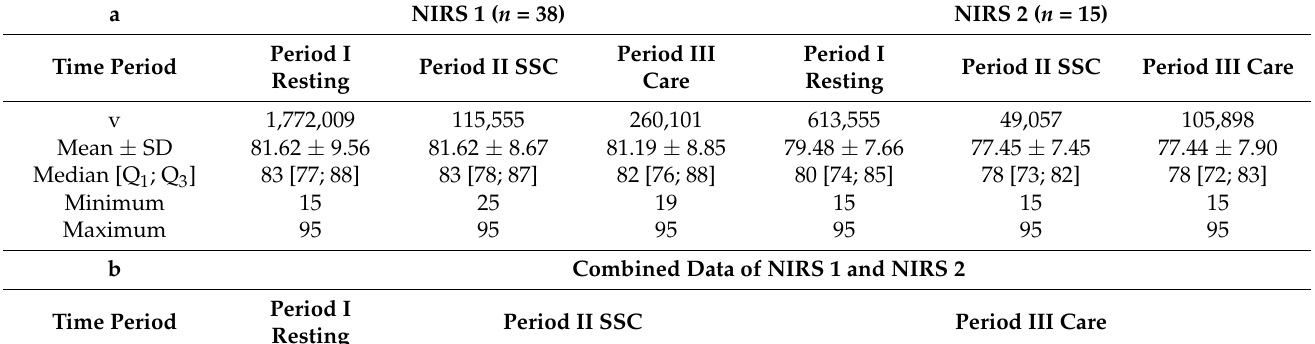
Table 3. a, b: Regional cerebral oxygenation (rcSO 2 ) in % during period I (resting time) period II (skin-to-skin-contact; SSC) and period III (handling) for infants with SSC based on all available values (3a) or median values (3b) of infants during each period with an overview of the number of values per infant, which were used to evaluate the median value per infant. The results of the generalized linear model (GLMM) are shown in the last part (3c). Predictions using the estimate and standard error have to be rescaled for the 0–1-problem and the [15; 95] interval limitation. v is the number of available values in all infants, SD is standard deviation, Q is quartile, SE is standard error, OR is odds ratio and CI is confidence